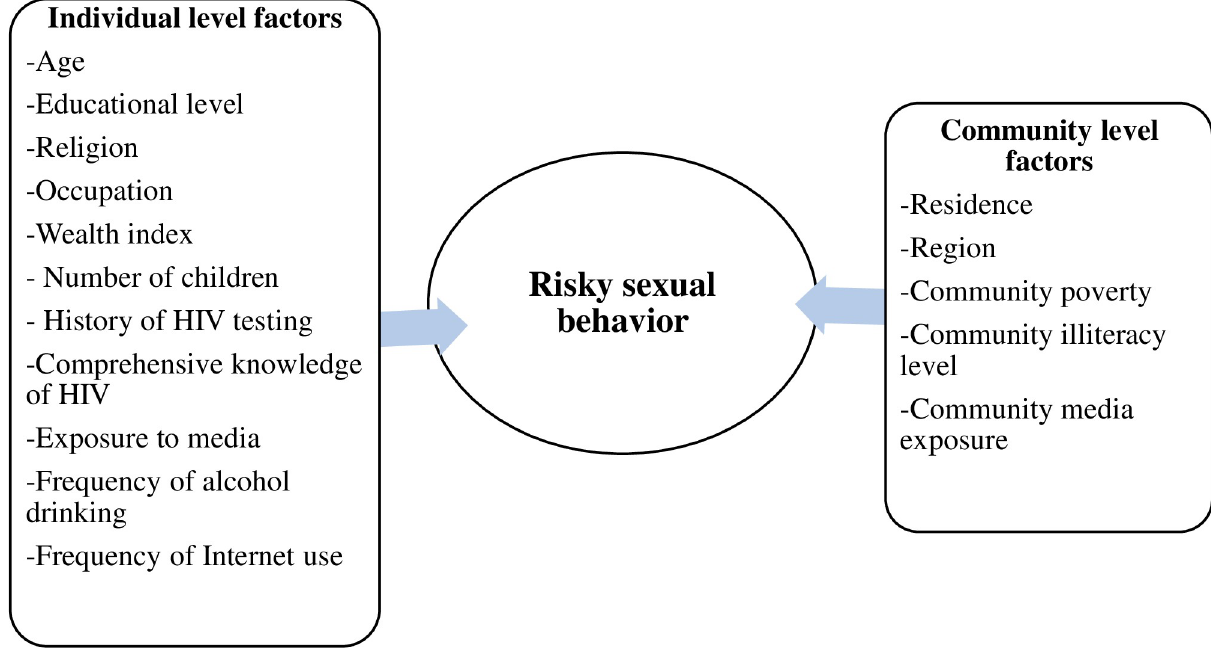
Fig 1. A conceptual framework for determinants of risky sexual behavior among unmarried men in Ethiopia.